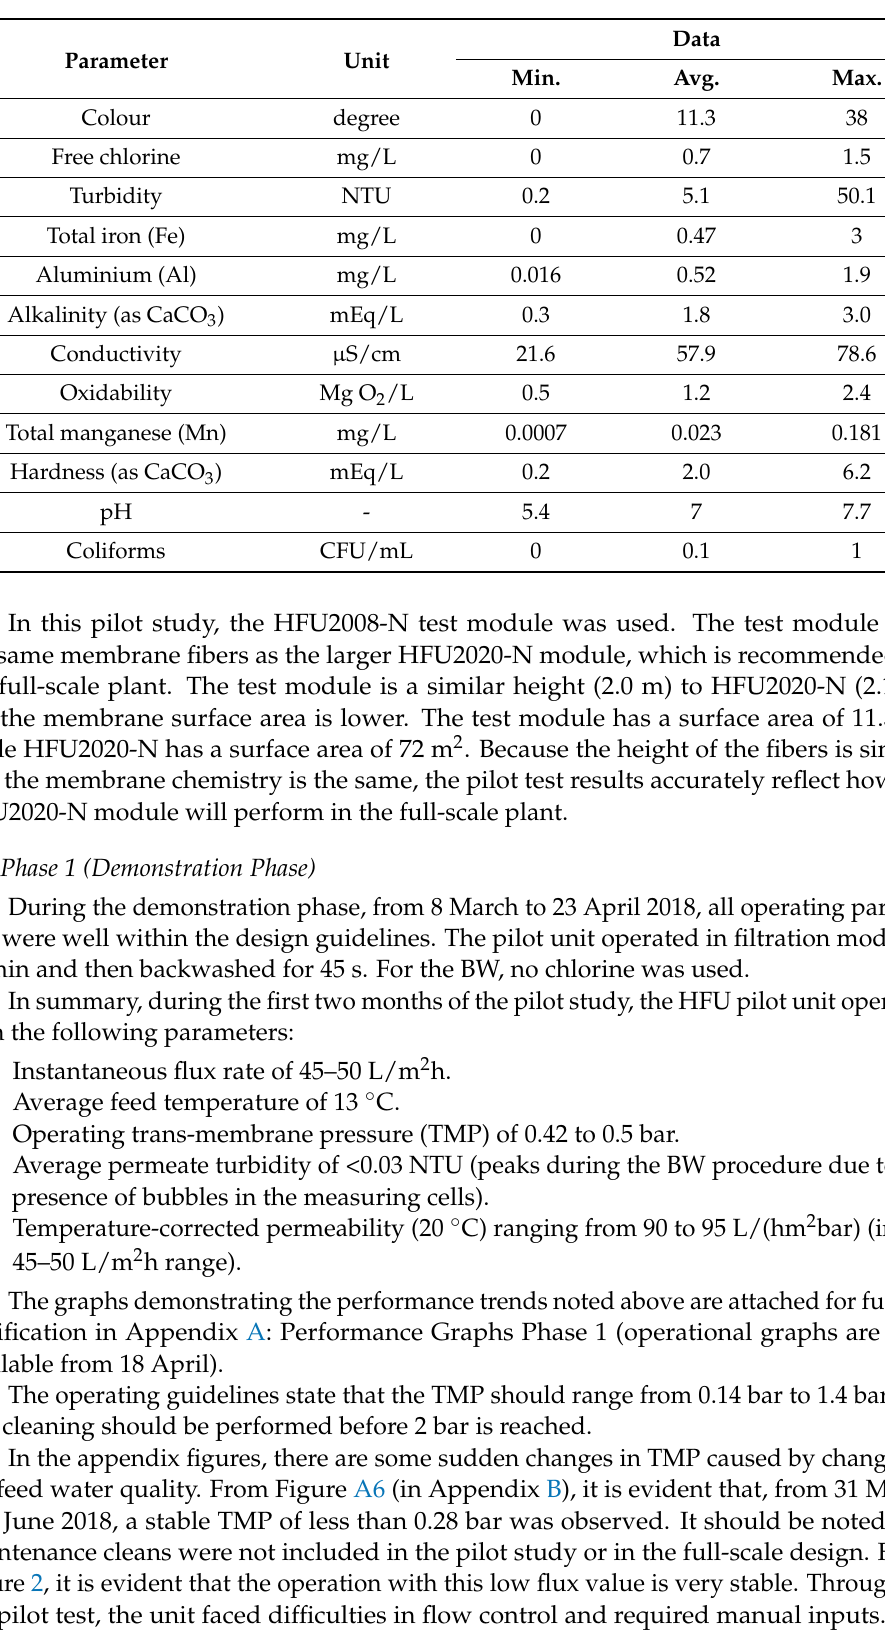
Table 3. Raw water analysis measured during the pilot